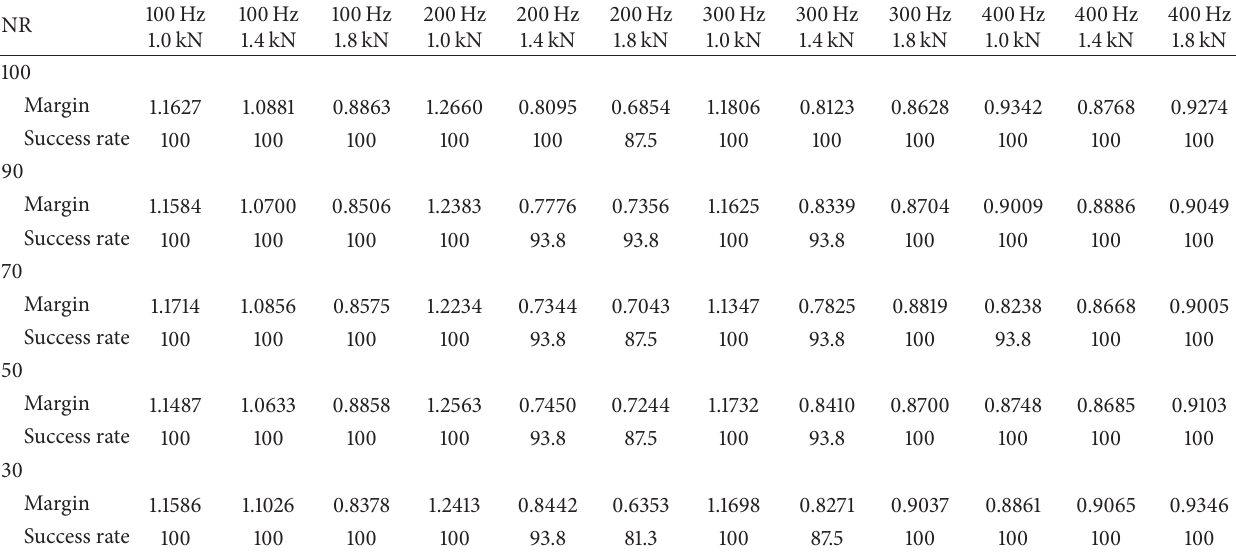
Table 7: The results of using different trial numbers (NR) using PIEEMD (SNR = 10) for 𝑌